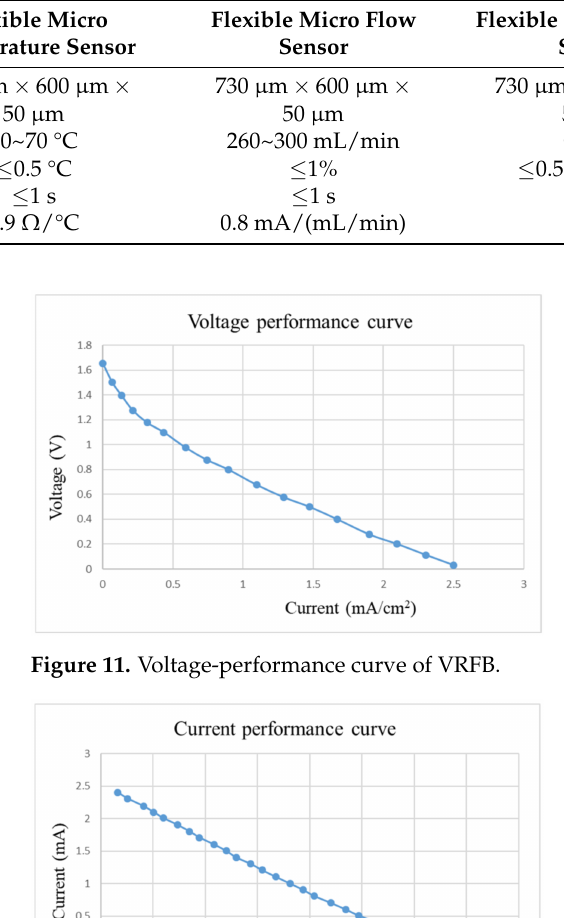
Table 1. Detailed specifications of the flexible, integrated micro-sensor [16].